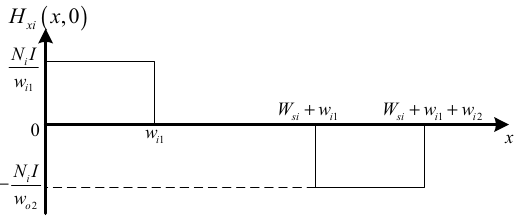
Figure 13. Expression of magnetic field intensity H xi ( x ,0 )